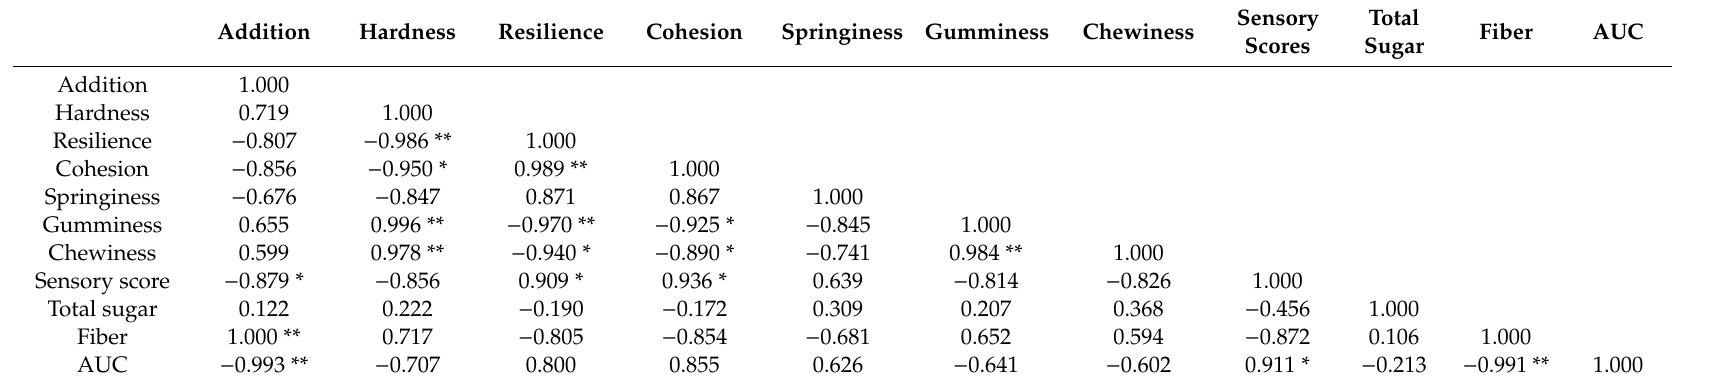
Table 7. Correlation between SCR addition and texture, sensory evaluation and